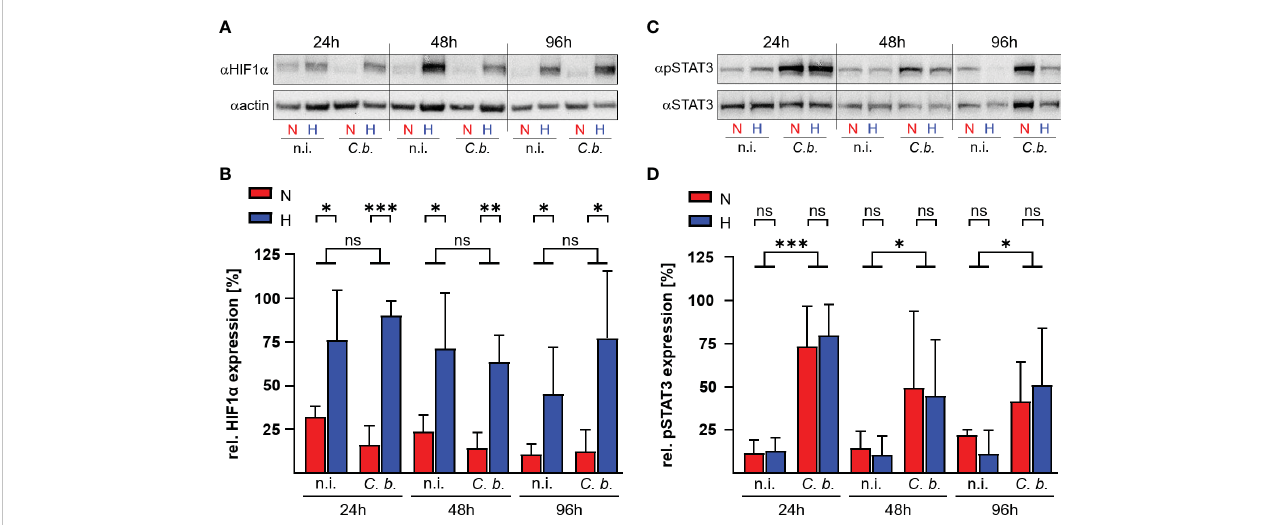
FIGURE 4 C. burnetii infection induces STAT3 activation in hypoxic bovine macrophages. Bovine monocyte derived macrophages were infected ( C. b. ) or not infected (n.i.) with C . burnetii NMII for the time periods indicated and kept under normoxic (N) or hypoxic (H) conditions. (A, B) The samples were subjected to immunoblot analysis using antibodies against HIF1 a or actin. (A) One representative immunoblot of three independent experiments with similar results is shown. (B) The ratio of HIF1 a to actin expression was calculated using ImageJ. Mean ± SD, n = 3, student´s t-test. ***p<0.001, **p < 0.01, *p < 0.05, ns>0.05. (C, D) The samples were subjected to immunoblot analysis using antibodies against phospho-STAT3 (pSTAT3) or STAT3. (C) One representative immunoblot of three independent experiments is shown. (D) The ratio of pSTAT3 to STAT3 expression was calculated from the immunoblots using ImageJ. Mean ± SD, n = 3, unpaired t-test. ***p<0.001, *p<0.05,